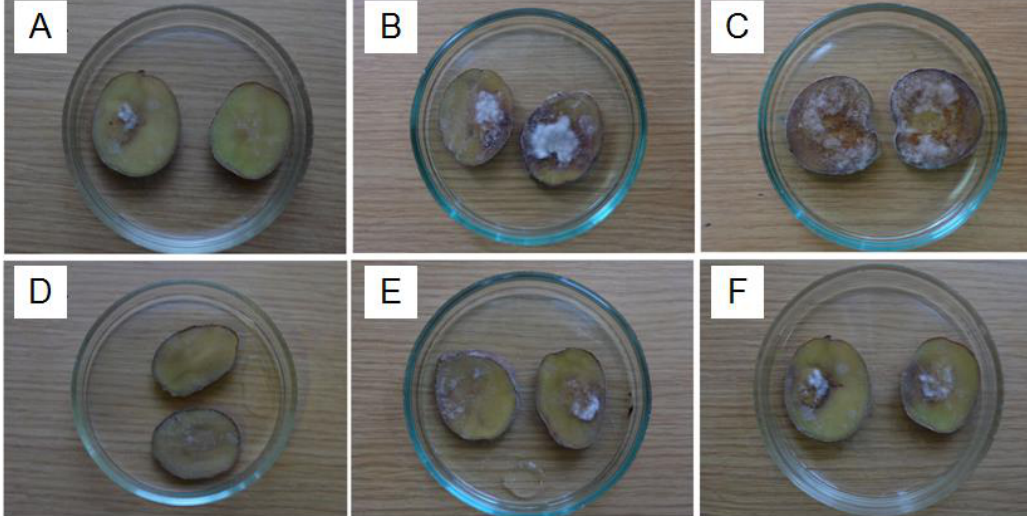
Figure 3. Dynamics of late blight disease development on potato tuber discs: ( A )—control since 96 h after inoculation, ( B )—control since 120 h after inoculation, ( C )—control since 144 h after inoculation; ( D )—PE-Eqi since 96 h after inoculation, ( E )—PE-Eqi since 120 h after inoculation, ( F )—PE-Eqi since 144 h after inoculation.